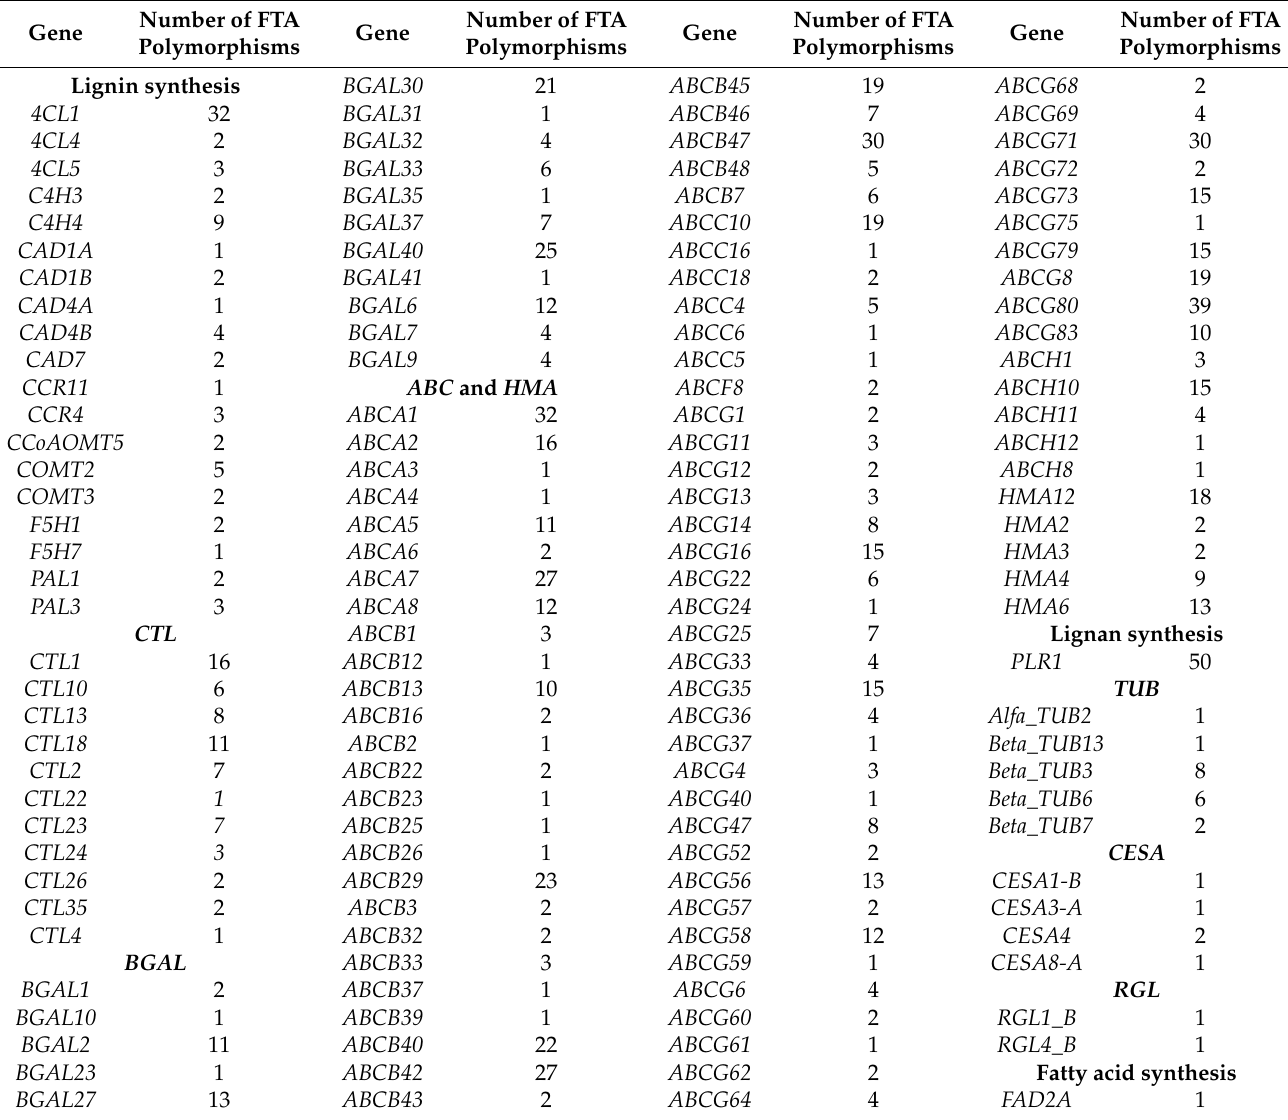
Table 1. Number of flax type-associated polymorphisms (r s ≥ 0.4 or ≤− 0.4) for genes of the 4CL , C4H , CAD , CCR